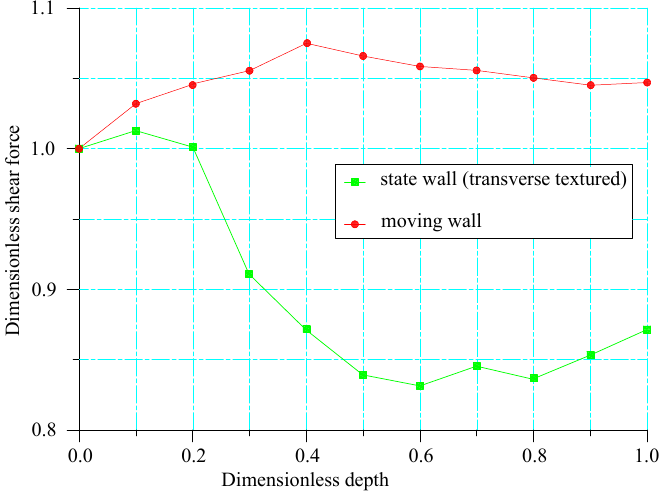
Figure 16. Influence of transverse texture depth on dimensionless shear